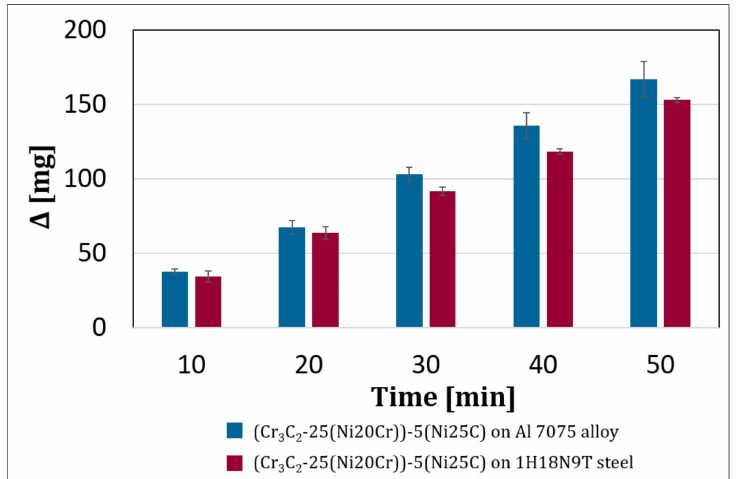
Figure 12. Mass loss versus time during the abrasive wear